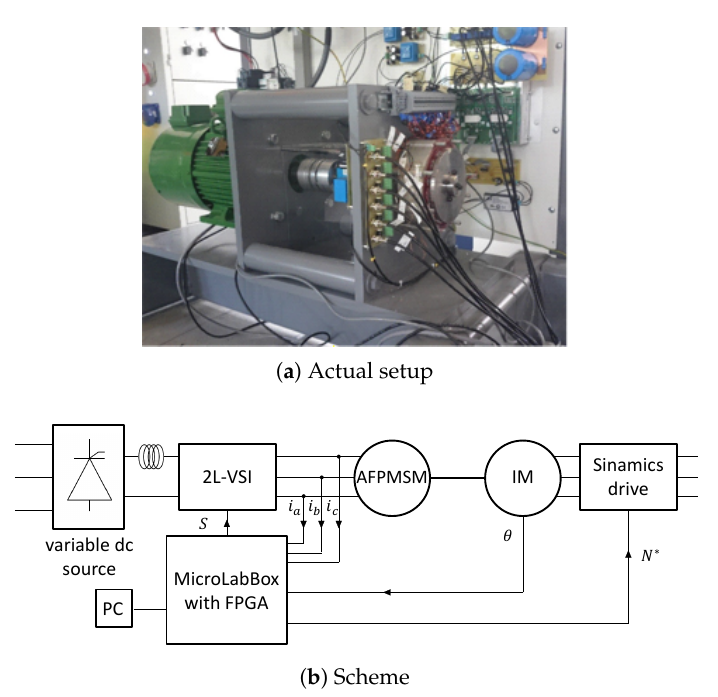
Figure 6. Test setup for the YASA AFPMSM.